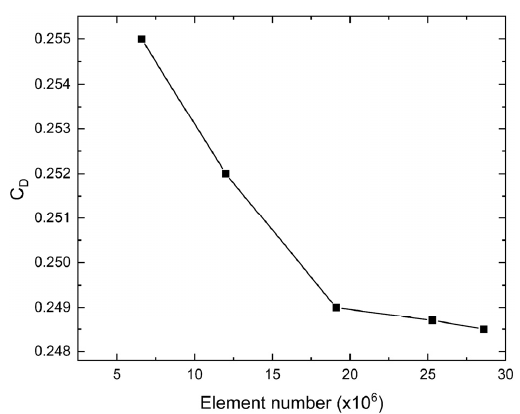
Figure 5. Mesh dependent test.